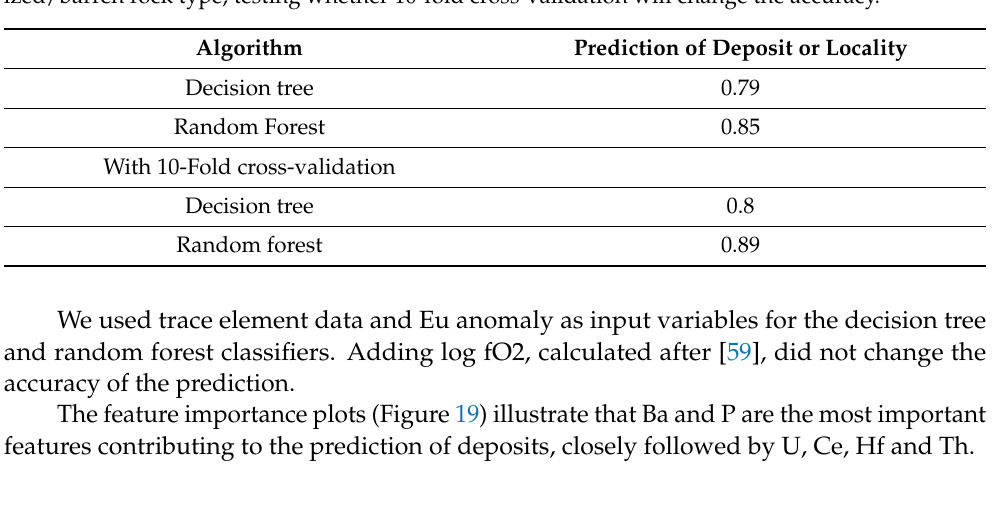
Figure 17. Pairplot for P, Lu, Hf and the calculated log fO2, data split by deposit. Table 1. Comparison of prediction accuracy for deposit and the mineralized/weakly mineral- ized/barren rock type, testing whether 10-fold cross-validation will change the